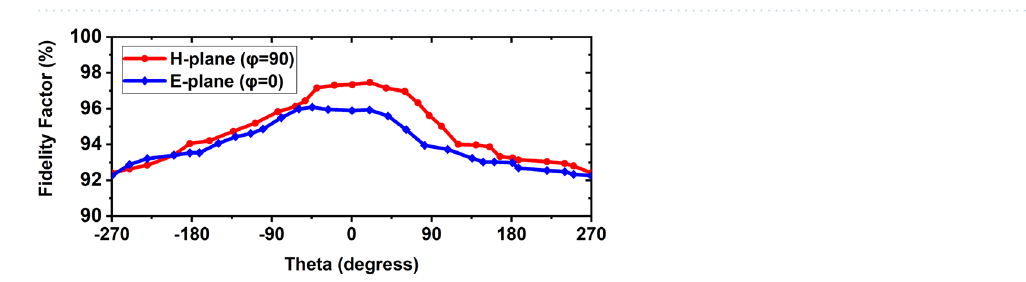
Figure 14. Fidelity factor (FF) measurements in E-plane and